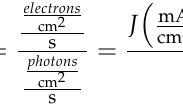
Table 1. IPCE of two films [PDDA/Ni25] 6 and PDDA/[Ni25/(PDDA – rGO)] 6.